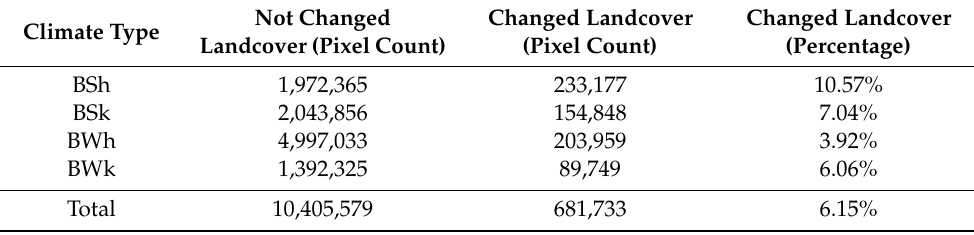
Figure 7. The land cover changes between 2010 and 2019, red color refers to the areas that has changed in terms of land cover types. Table 1. The areas of changed landcover between 2010 and 2019 presented by pixel counts.